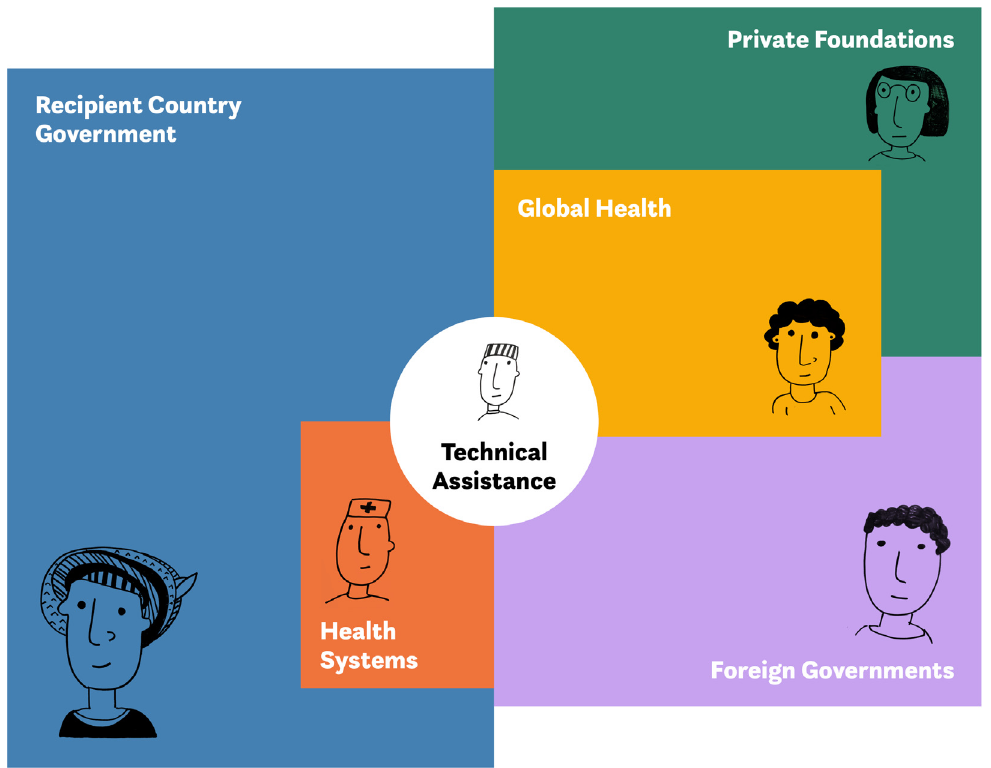
Figure 1. Technical assistance actors, services, and interactions. Note: Has been reproduced with permission from Sonder Collective, 2020 22